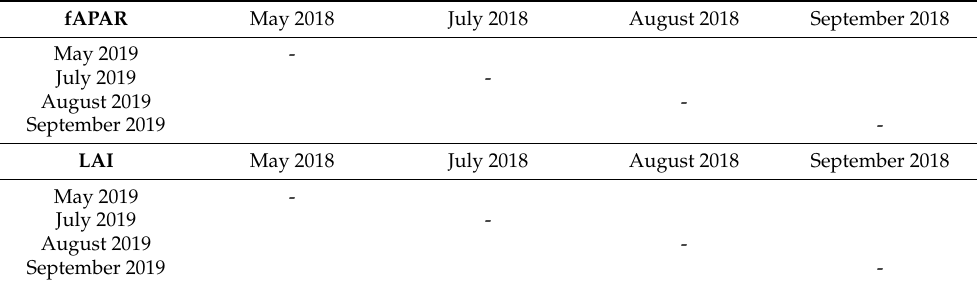
Table A1. Kruskal–Wallis test results for between year separability comparison of leaf area index (LAI) and absorbed photosynthetically available radiation (fAPAR). The presence of *** denotes that the null hypothesis was rejected and that the samples are significantly different at p = 0.05 level.